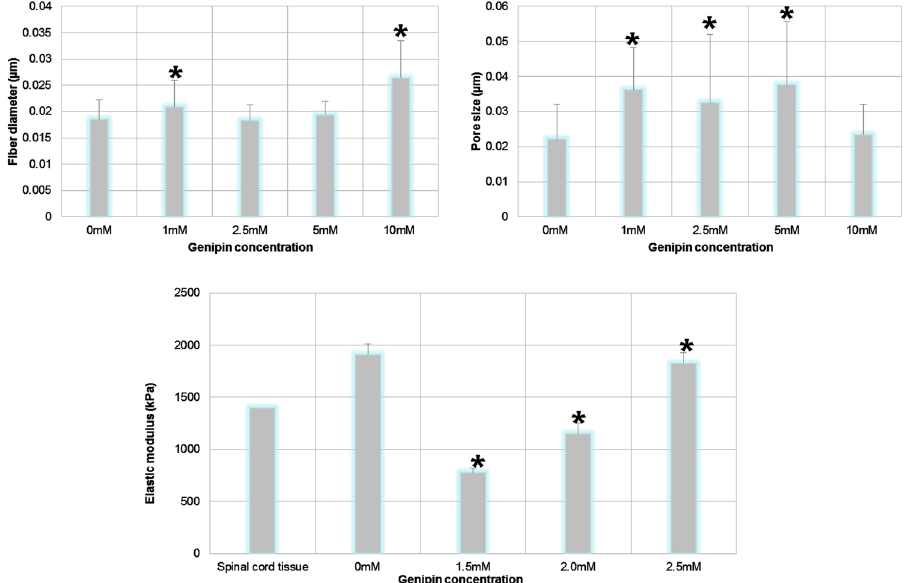
Figure 5. Genipin crosslinking influences the morphological and mechanical properties of fibrin scaffolds. ( A ) The effect of genipin concentration on fiber diameter (biological n = 3, technical n = 10). ( B ) The effect of genipin concentration on pore size of fibrin scaffolds (biological n = 3, technical n = 30). ( C ) The effect of genipin on elastic modulus. The elastic modulus for spinal cord tissue is taken from 37 . Each group is represented by its mean average with error bars indicating the S.E.M. * Indicates p < 0.05 compared to control (0